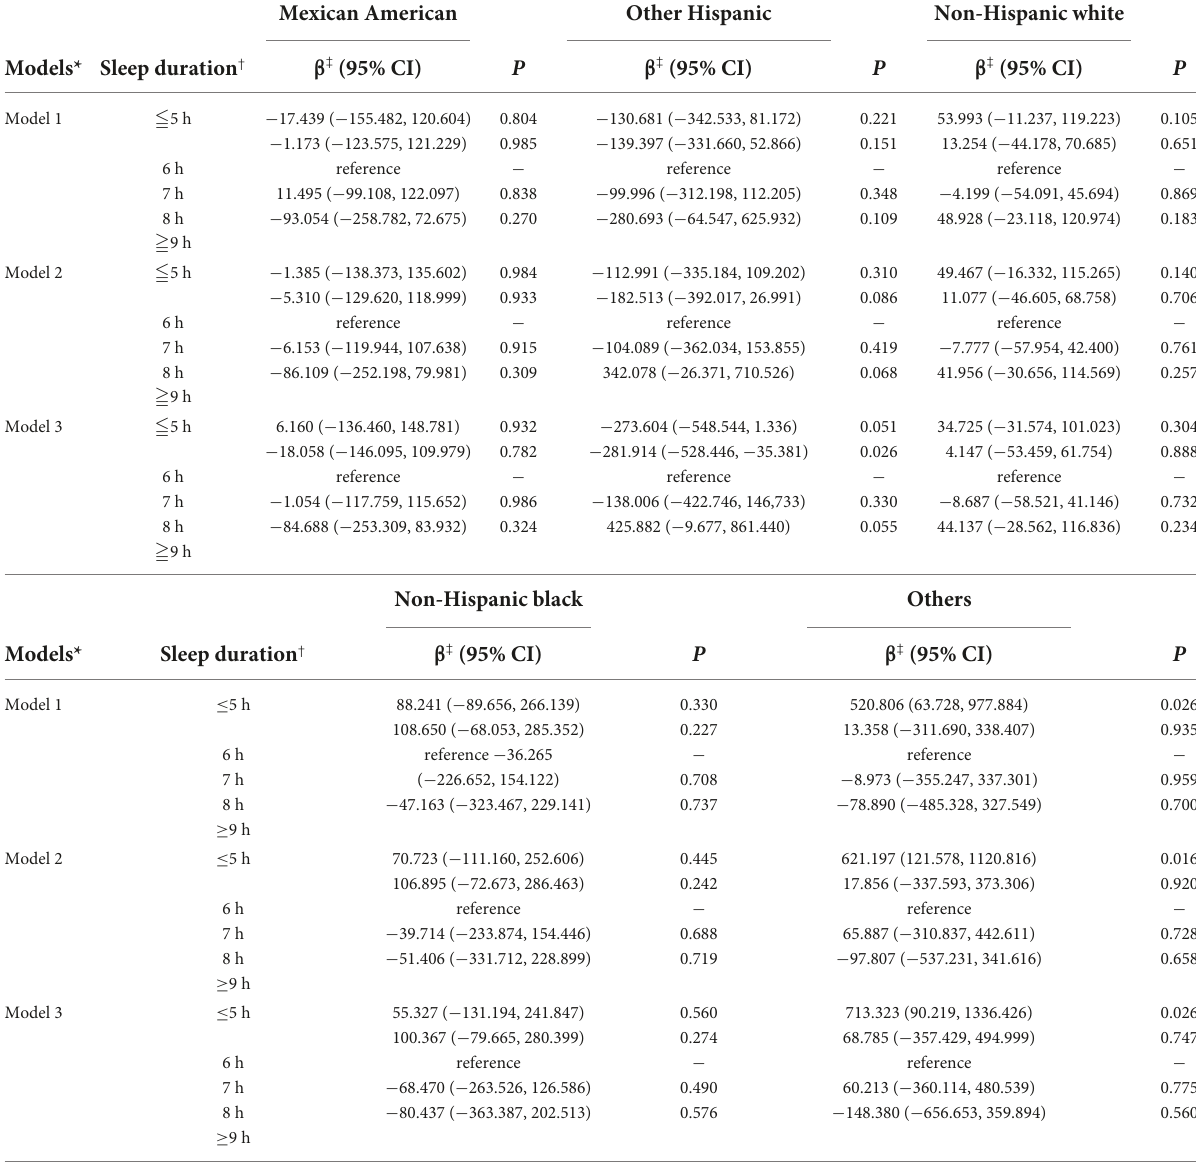
TABLE 3 Race specific association between sleep duration and serum immunoglobulin E (IgE) level. Mexican American Other